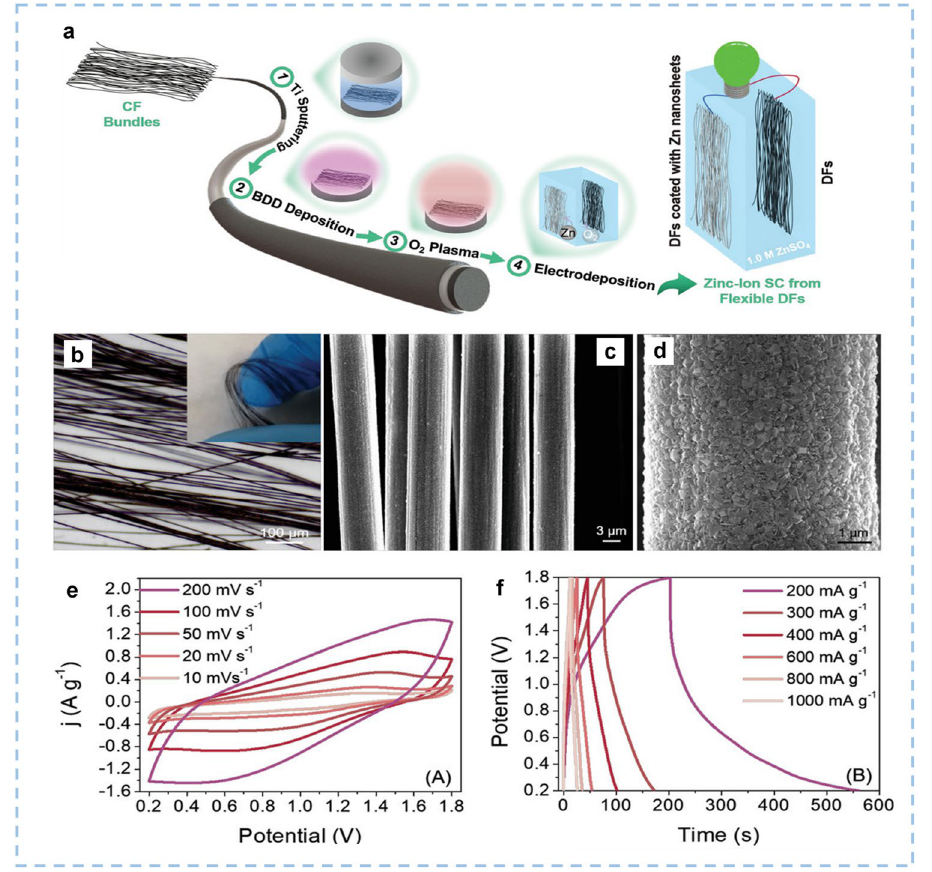
Fig. 7 The synthesis procedure, morphology, and structure of the flexible DFs and electrochemical performance of the as-assembled zinc-ion SC in 1 M ZnSO 4 . a Schematic illustration of DFs. b Optical micrograph with an inset digital photograph. c , d FESEM images (secondary electron mode). e CV curves at different scan rates, f GCD curves at different current densities. Reproduced with permission. Reproduced